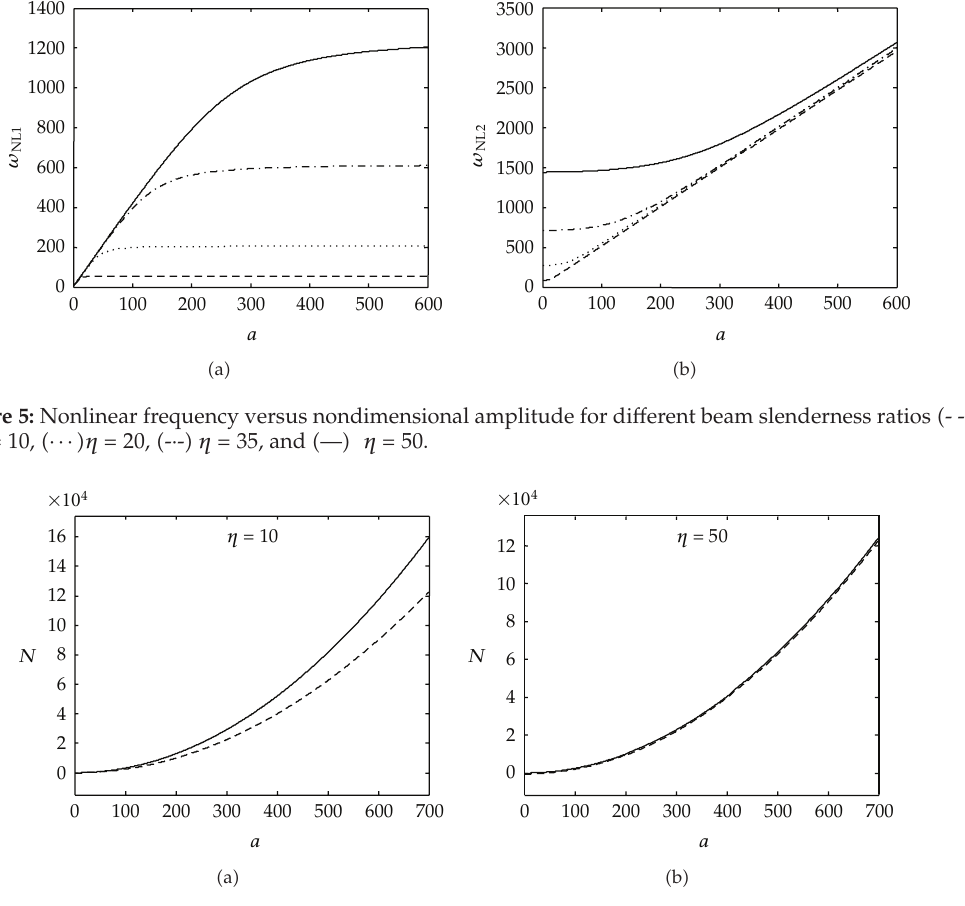
Figure 6: Variation of the nondimensional buckling load versus nondimensional amplitude for di ff erent beam models and di ff erent slenderness ratios (cid:2) - - - (cid:3) Bernoulli-Euler’s and Rayleigh’s, (cid:2) — (cid:3) shear and Timoshenko’s beam